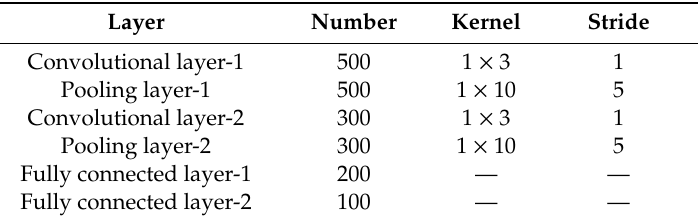
Table 3. Structure of crude oil film absolute thickness inversion module. Layer Number Kernel Stride Convolutional layer-1 500 1 × 3 1 Pooling layer-1 500 1 × 10 5 Convolutional layer-2 300 1 × 3 1 Pooling layer-2 300 Fully connected